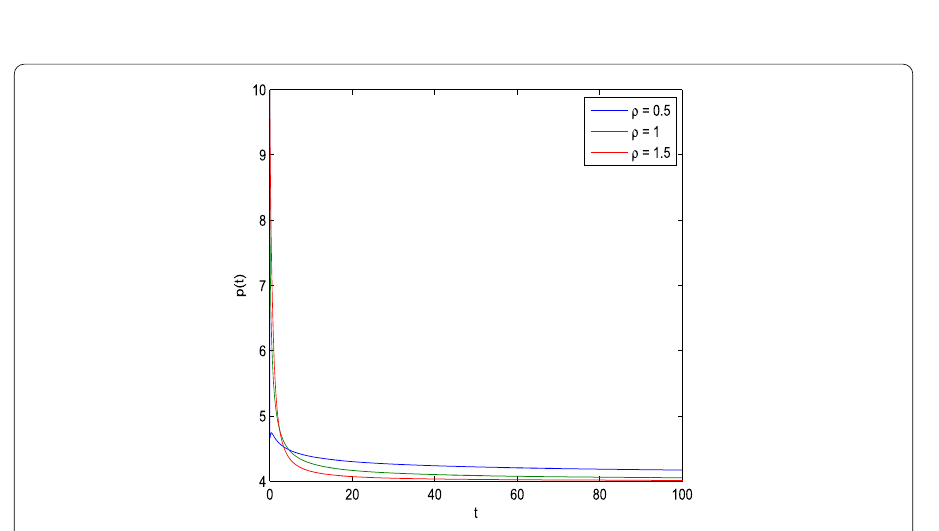
Figure 3 The values of p ( t ) (left) and the approximate values of p ( t ) (right) for Example 2 at various values of ρ and α = 0.7